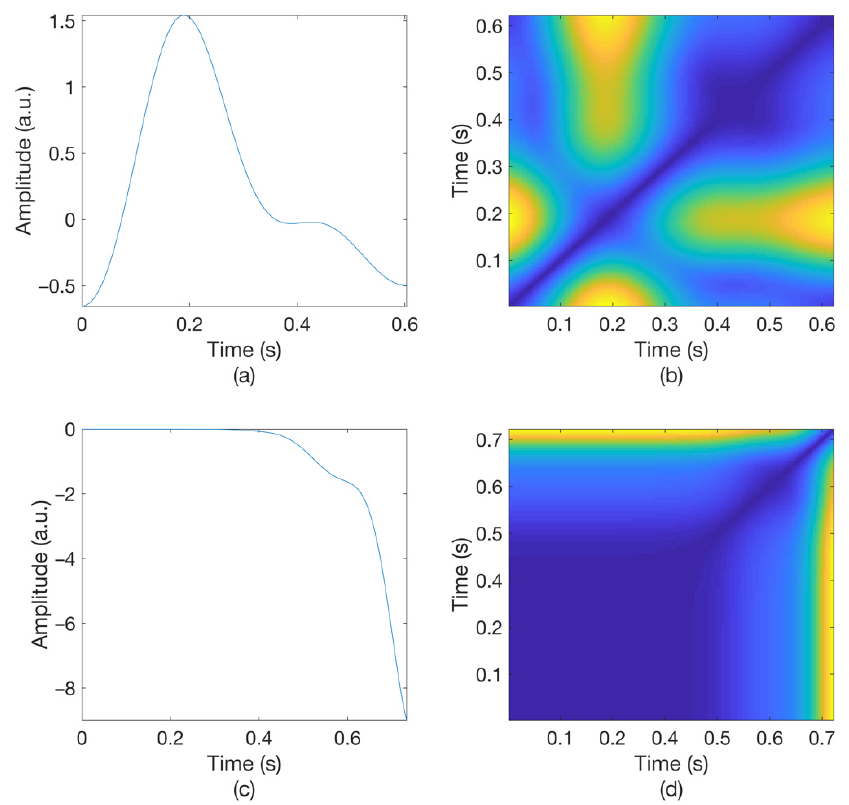
Figure 3. Examples of original waveform and the recurrence plot of photoplethysmogram segments. ( a ) Photoplethysmogram segment of ‘good’ class, ( b ) recurrence plot of ‘good’ class photoplethysmogram segment, ( c ) photoplethysmogram segment of ‘poor’ class, ( d ) recurrence plot of ‘poor’ class photoplethysmogram segment.